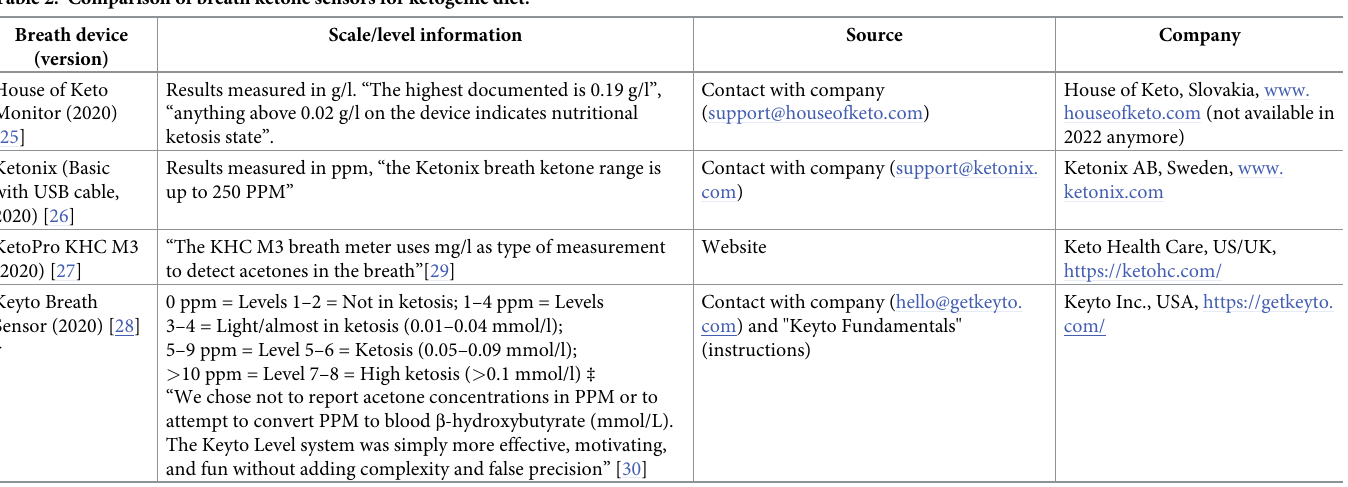
Table 2. Comparison of breath ketone sensors for ketogenic